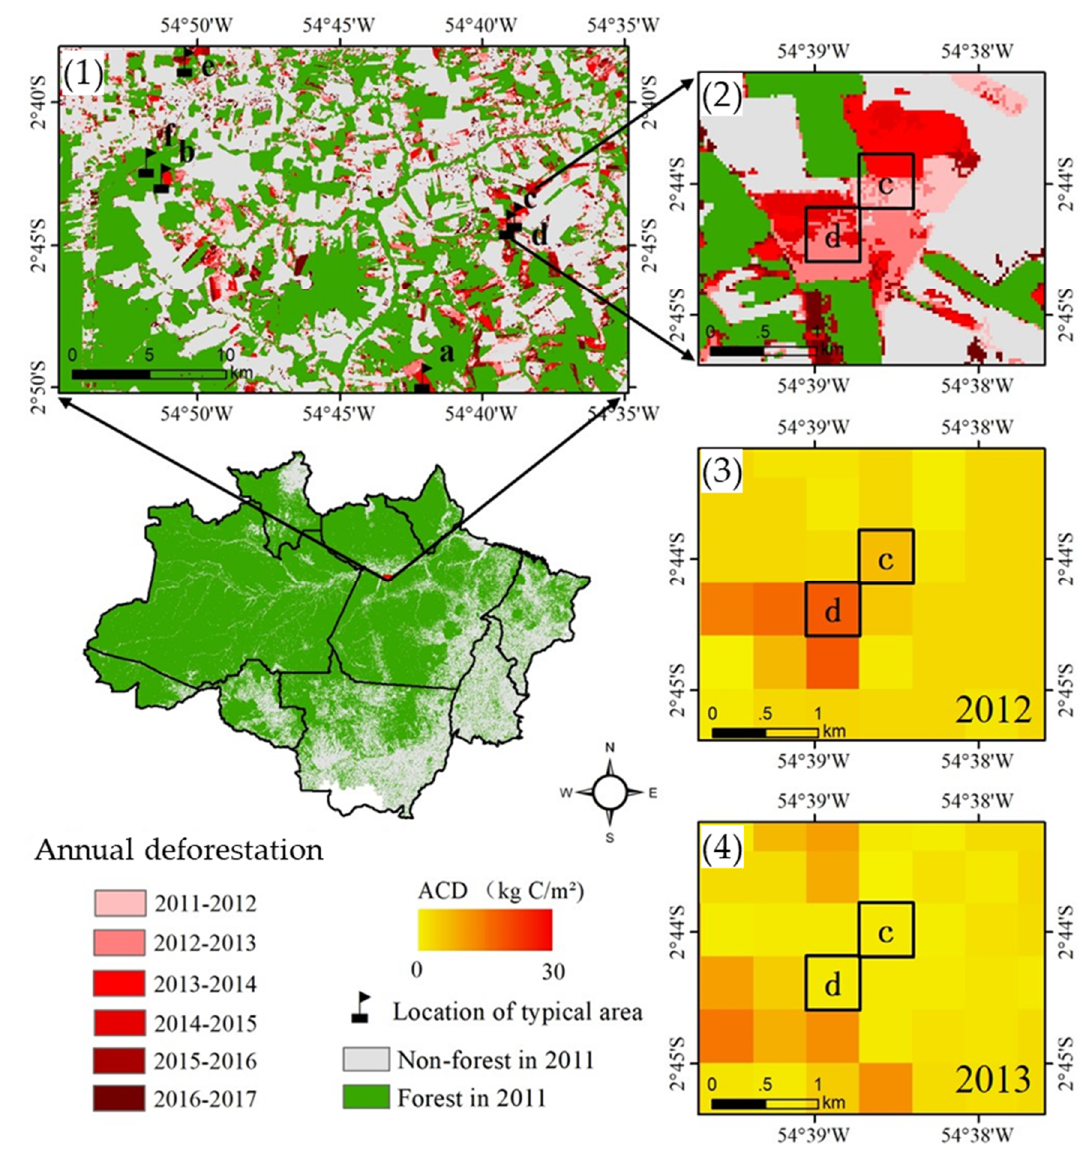
Figure 4. The strategy of linking deforestation images to ACD estimates to examine the impacts of deforestation rates on ACD dynamics: ( 1 ) annual deforestation image compiled from Landsat images in 2011–2017; ( 2 ) two plots with a window size of 17 × 17 pixels showing deforestation rates; ( 3 , 4 ) ACD estimates in 2012 and 2013, respectively, using random forest based on spectral indices from the MODIS data.